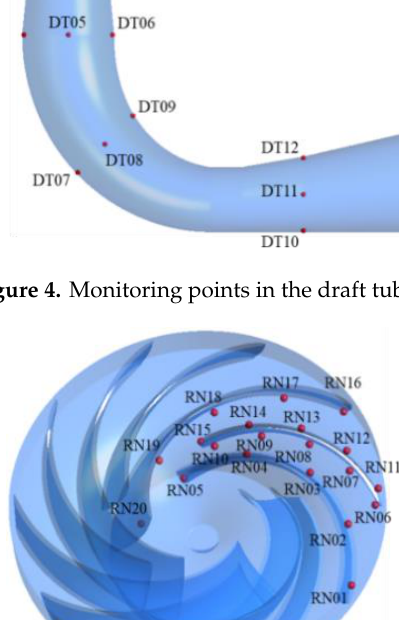
Figure 7. Monitoring points in the volute. 3.2. Theoretical Prediction The rotor–stator interaction between the runner and the guide vanes is the main reason for the high frequency fluctuation in the runner. In this paper, according to the diameter modulus theory proposed by Kubota [24] and the method for hydraulic excitation in the pump-turbine, analyzed by Tanaka [25], considering the special structure of the long and short blades, the relatively prominent rotor–stator interaction frequency in the pump-turbine with long and short blades is predicted from the theoretical level. Low-order and high-order hydraulic excitation modes can be induced by the rotor–stator interaction effect, dominated by potential flow. The modes can be expressed by the node diameter number k. The expressions of the minimum and maximum node diameters are as follows: 1